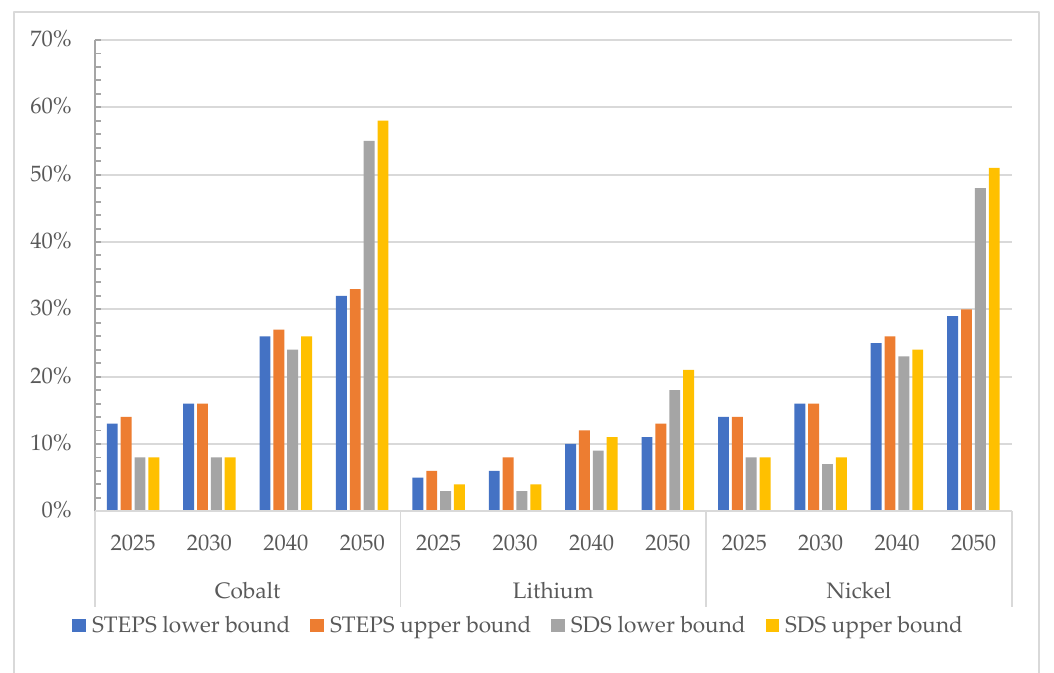
Figure 7. Recycled context projections under the SDS scenario and the STEPS scenario (Data Source: [38]).